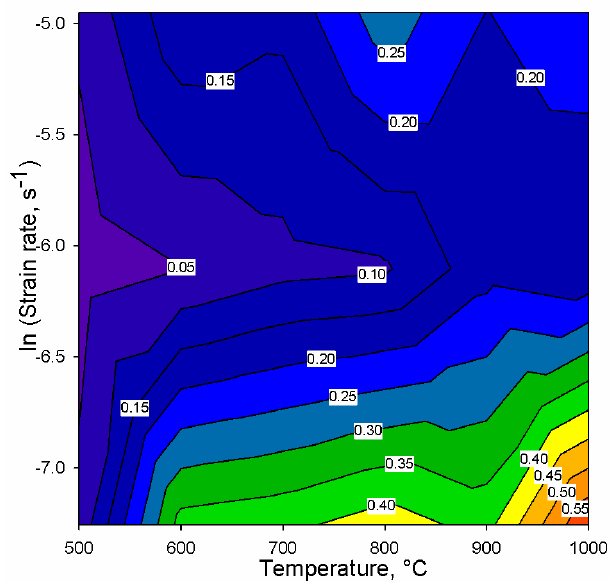
Figure 7. Processing map for the Ti-15Mo / TiB composite.